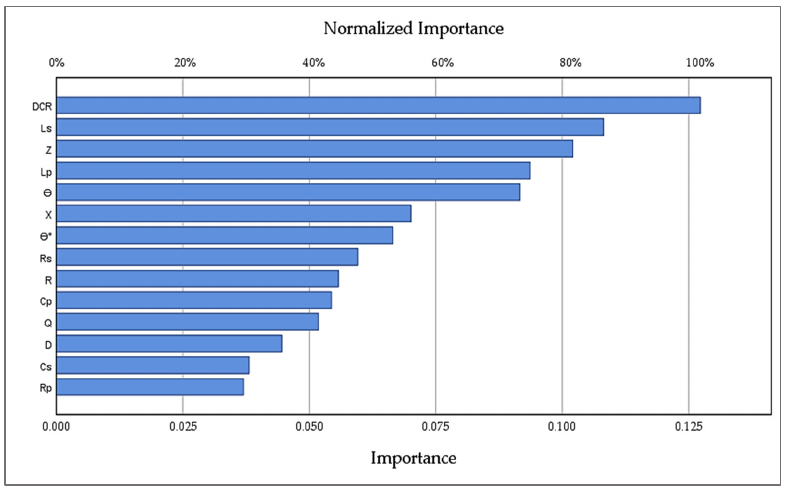
Figure 6. Importance of the independent variable electrical properties (Cs, Rs, D, Cp, Rp, Ls, Lp, R, X, DCR, Z, ϴ , ϴ °, and Q) at 10,000 Hz. Table 6. A comparison between the ANNs models’ errors in the training, testing, and holdout phases at various frequencies.